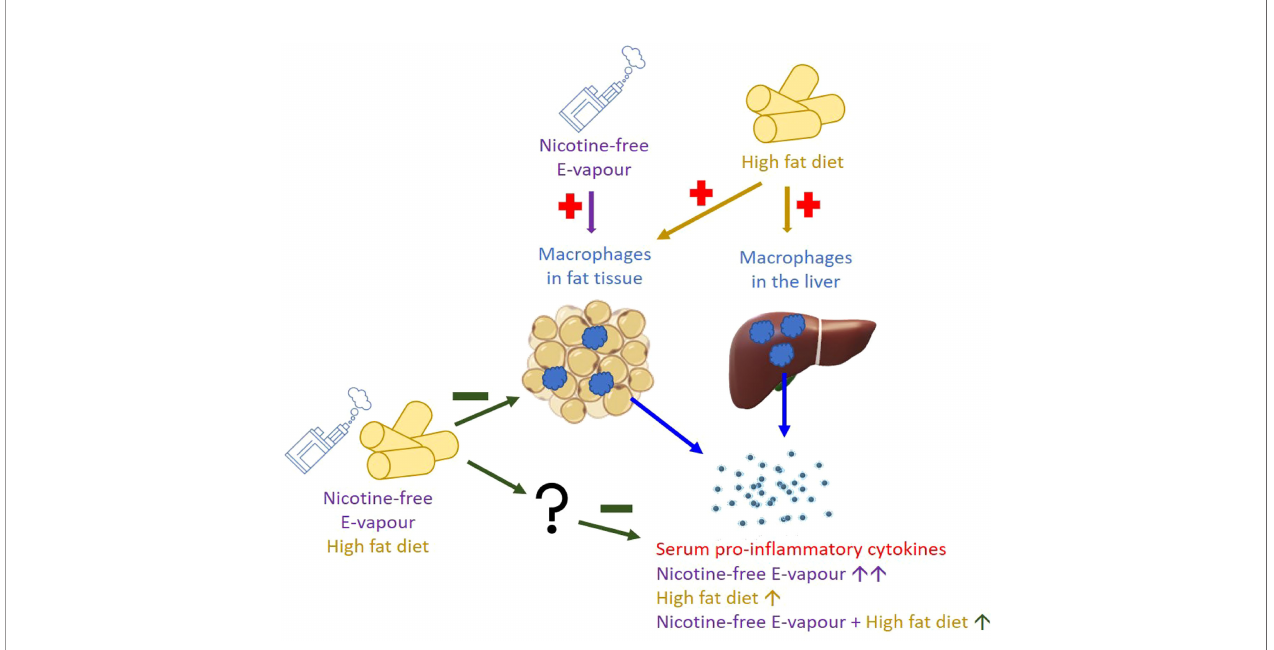
FIGURE 5 | Proposed working